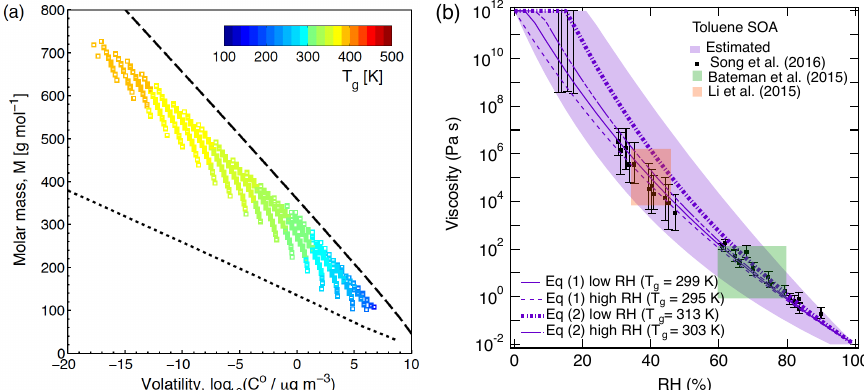
Figure 7. (a) Molecular corridor of molar mass plotted against the volatility of toluene SOA formed under dry conditions (Hinks et al., 2018) color coded by the glass transition temperature ( T g ) estimated using Eq. (2). The upper dashed line indicates the low O:C bound of the molecular corridor (linear alkanes C n H 2 n + 2 with O:C = 0), and the lower dotted line indicates the high O:C bound (sugar alcohols C n H 2 n + 2 O n with O:C = 1). (b) Comparison of the measured (markers) and modeled (lines) viscosity of toluene SOA at 295K as a function of RH. Viscosities were calculated using a fragility ( D) of 13, hygroscopicity ( κ) of 0.25, and a Gordon–Taylor constant ( k GT ) of 3.0 with different glass transition temperatures of dry SOA ( T g , org ) as estimated using Eqs. (1) or (2) under low and high RH conditions. The shaded regions were calculated by varying those parameters: T g , org = 313K (295K), κ = 0.20 (0.25), D = 13 (10), k GT = 2.5 (3.5) for the upper (lower) limit. Mass loadings were 23µgm − 3 for low RH and 8µgm − 3 for high RH (Hinks et al.,